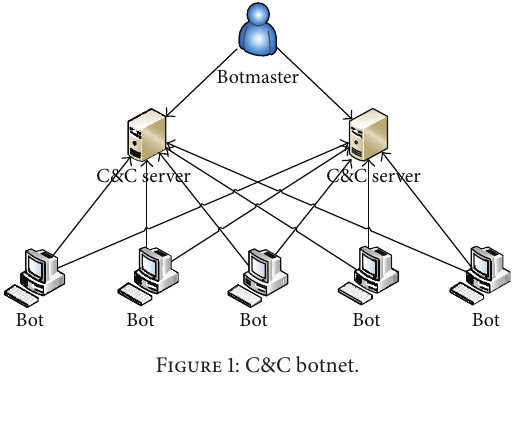
Figure 1: C&C botnet.